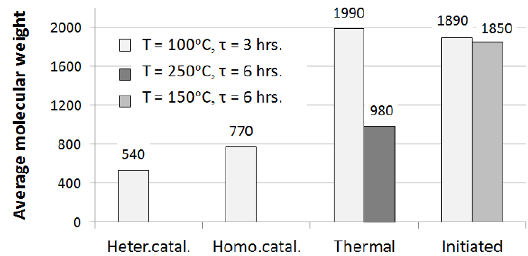
Figure 2. Average molecular weight of the cooligomers synthesized by different methods.